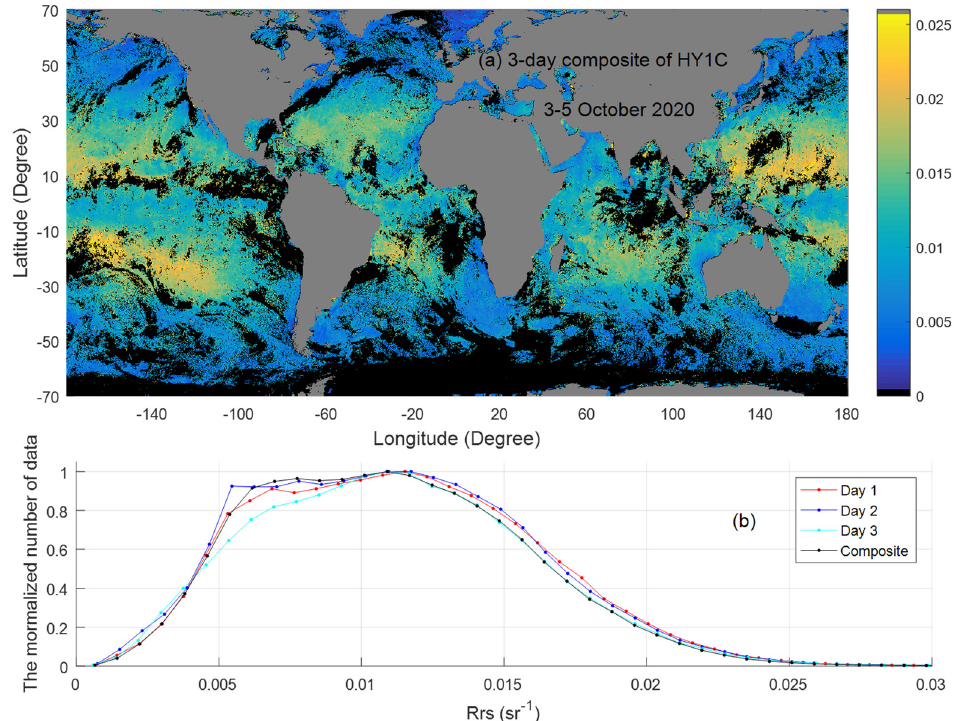
Figure 11. ( a ) The 3-day composite R rs image at Band 1, merged from HY-1C during 3–5 October 2020, and ( b ) the comparison of the R rs data distribution of the images.